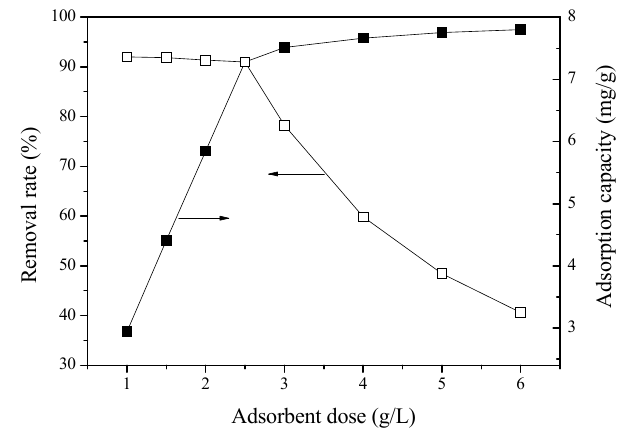
Figure 8. Effect of adsorbent dose on the adsorption of Ni 2+ by synthesized zeolite (pH 5, contact time 30 min, initial Ni 2+ concentration 20 mg/L). 30 min, initial Ni 2+ concentration 20